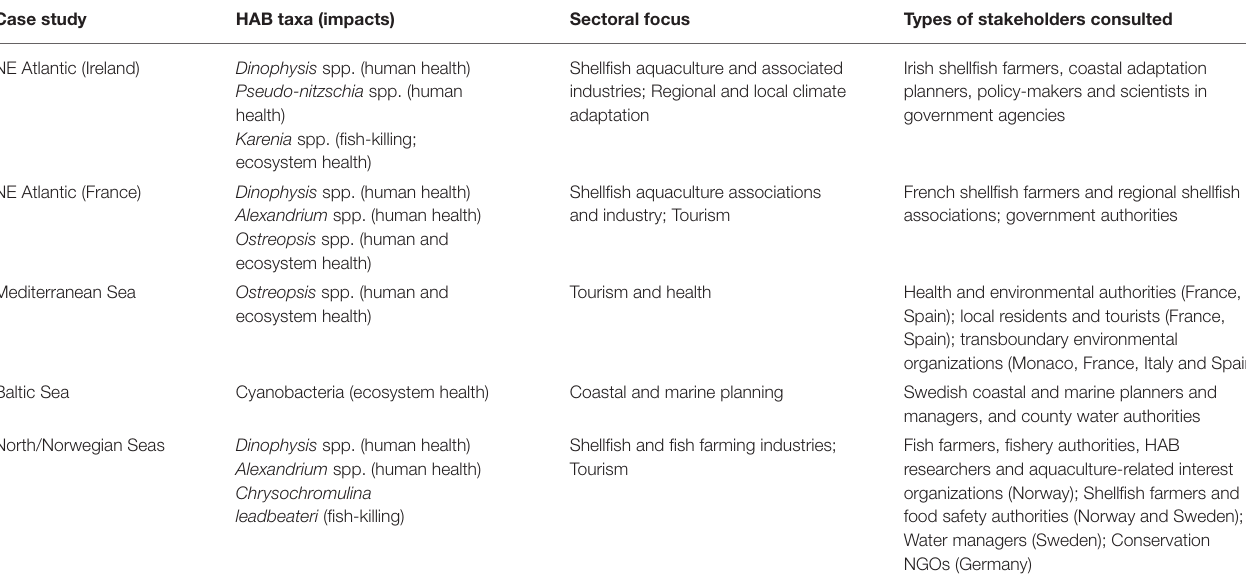
TABLE 1 | Summary of the CoCliME case studies discussed in this paper, the HAB taxa addressed, the sectors impacted and types of stakeholders consulted. Case